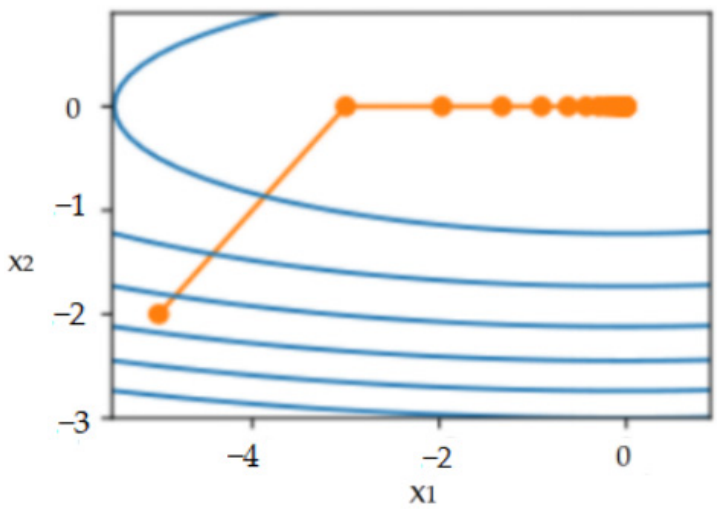
Figure 1. Gradient descent simulation process of AdaDelta optimizer.